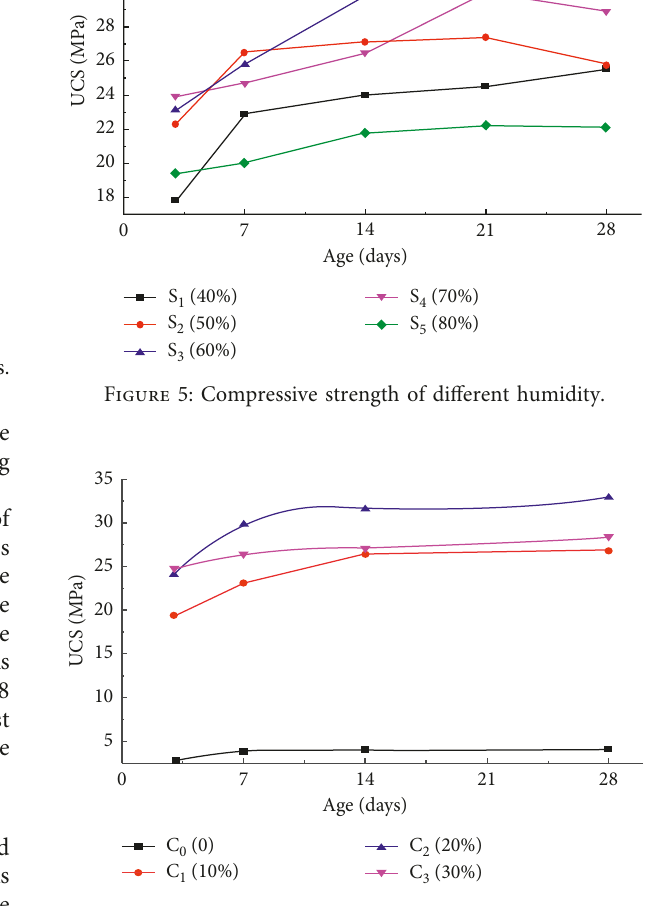
2 concentrations.